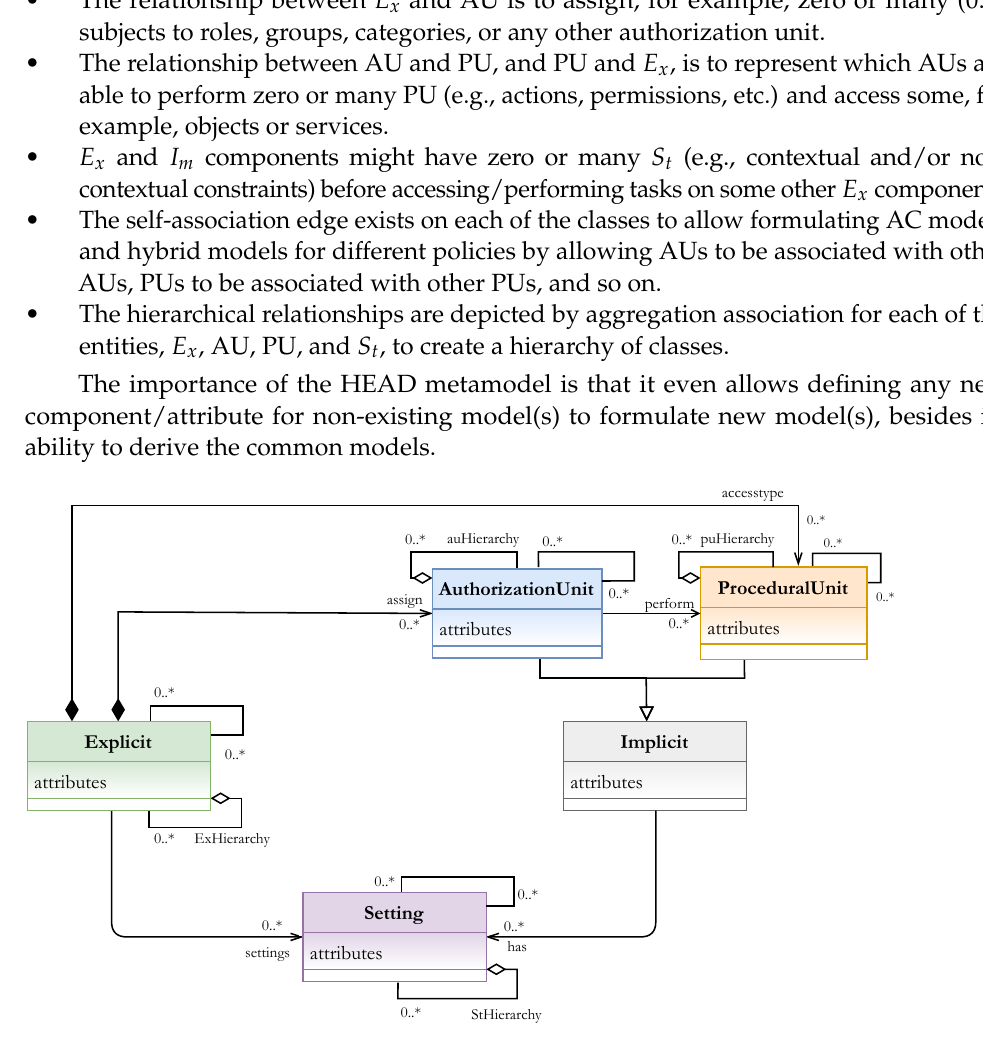
Figure 17. HEAD metamodel